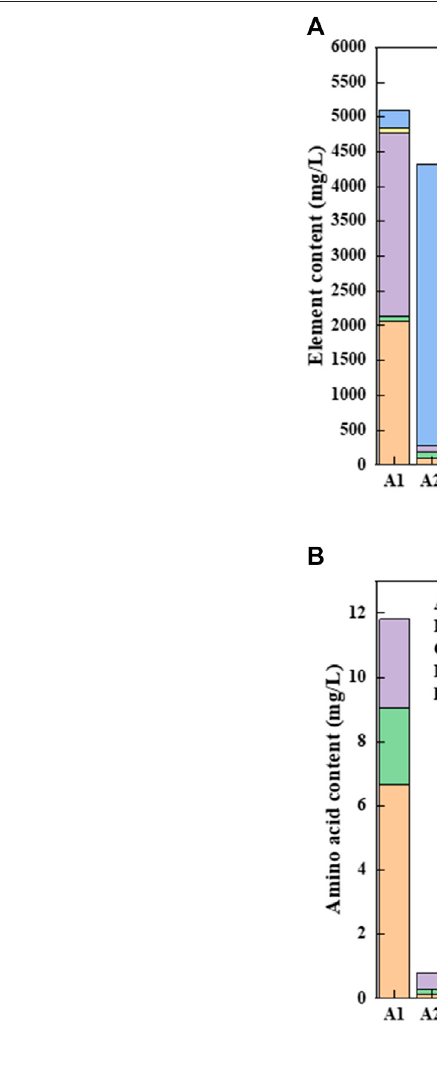
Frontiers in Bioengineering and Biotechnology |